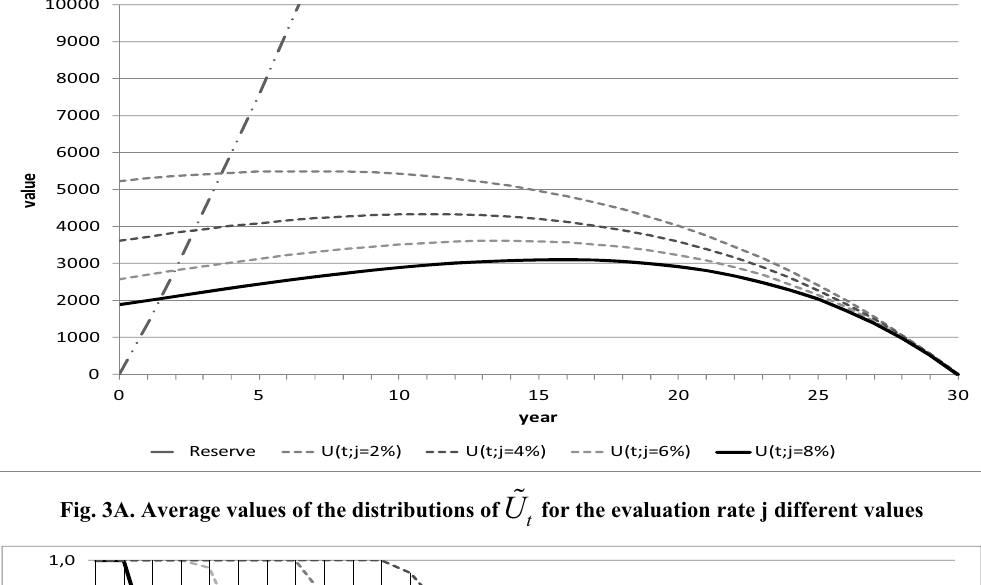
Fig. 3A. Average values of the distributions of